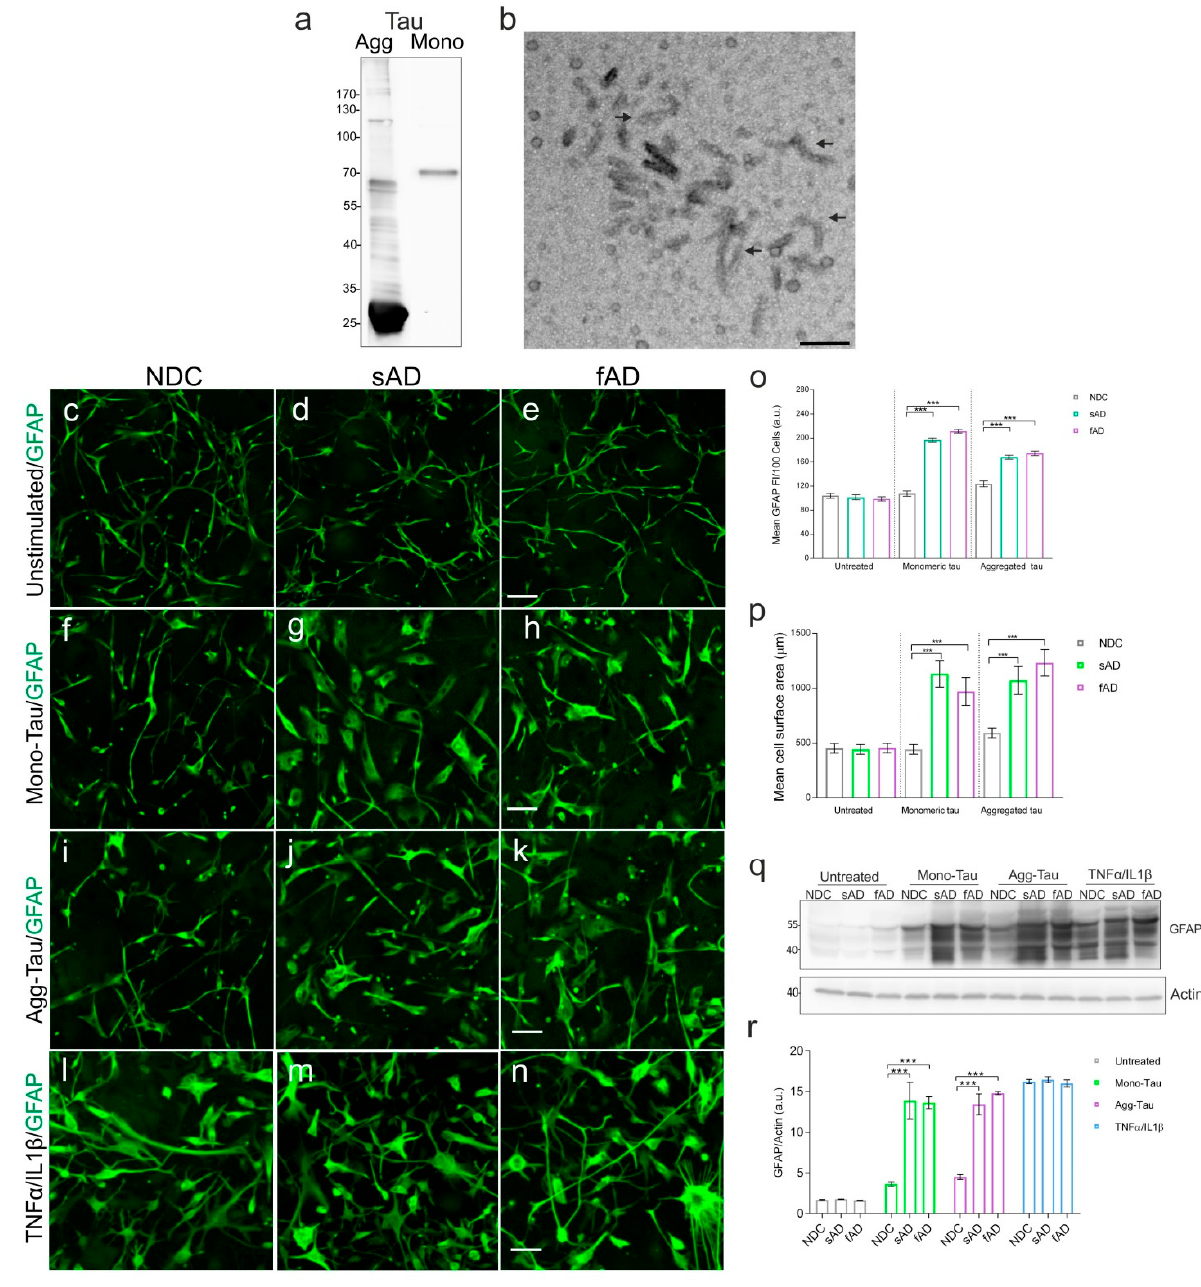
Figure 3. Astrocytes derived from AD behave differently to monomeric and aggregated tau in vitro. ( a ). Western blot showing aggregated and monomeric tau used in the study. ( b ). Electron mi- croscope image of the aggregated tau preparation used in the study (arrows indicate tau fibrils and short filaments). Representative confocal images of GFAP-positive astrocytes. ( c – e ) Untreated, ( f – h ) astrocytes upon stimulation with monomeric and ( i – k ) aggregated tau. ( l – n ) Proinflammatory cytokine TNF α /IL1 β cocktail was used as positive control to show astrocyte reactivity in all cases. Scale bar: 50 µ m. ( o ) Graph showing difference in mean fluorescent intensities ( ± SD) of GFAP between the untreated iPSC-derived astrocytes and after exposure to monomeric and aggregated tau. ( p ) Graph showing mean surface area of cells pre- and poststimulation with monomeric and aggregated tau. ( q ) Western blot using anti-GFAP antibody using cell lysates from untreated, or after stimulation with monomeric, aggregated-tau or TNF α /IL1 β cocktail. ( r ) Graph showing the levels of GFAP between the groups. One-way ANOVA followed by Tukey’s multiple comparisons tests, n = 3/group; n = 3 experimental repeats, and *** p <